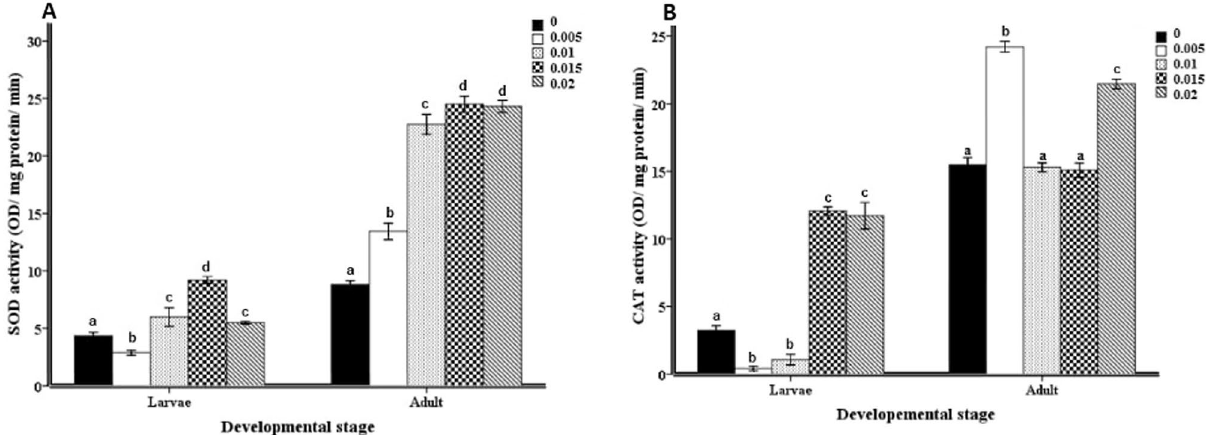
Figure 2. Activity of antioxidant enzymes in form of: ( A ) superoxide dismutase (SOD), ( B ) catalase (CAT), and ( C ) polyphenol oxidase (PPO) (OD/ mg protein/ min). The enzymes activity was expressed as mean ± SE values. The enzymatic antioxidant activity obtained from gut homogenates of 5th instar larvae and males of Hermetia illucens which their food containers were exposure different concentration of malathion (0, 0.005, 0.01, 0.015, 0.02 mg/ml). Mean values marked with the different lowercase letters were significantly different among malathion concentration assessment (ANOVA test Tukey’s-b , Post Hoc test, p < 0.05).